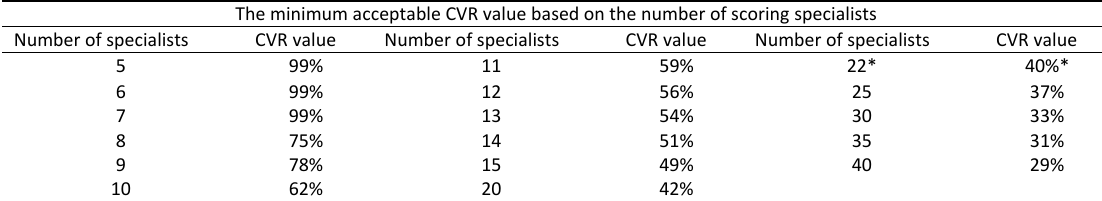
Table 1. The minimum acceptable CVR value based on the number of scoring specialists. (Hajizadeh and Asghari, 2011)